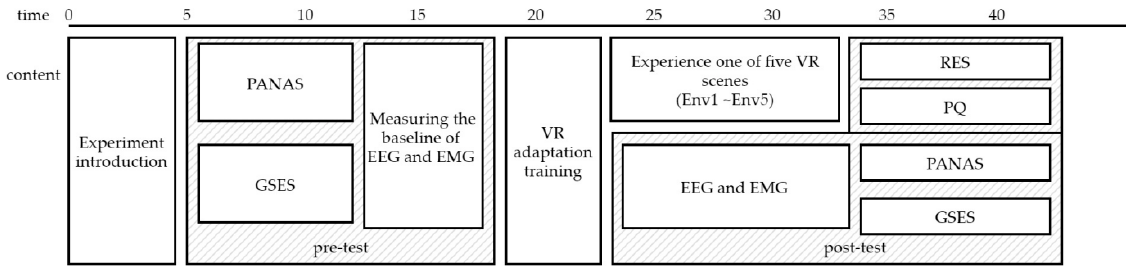
Figure 10. Experimental procedure. PANAS: Positive and Negative Affect Scale, GSES: General Self-Efficacy Scale, EEG: Electroencephalography, EMG: Electromyography, PQ: Presence Questionnaire.